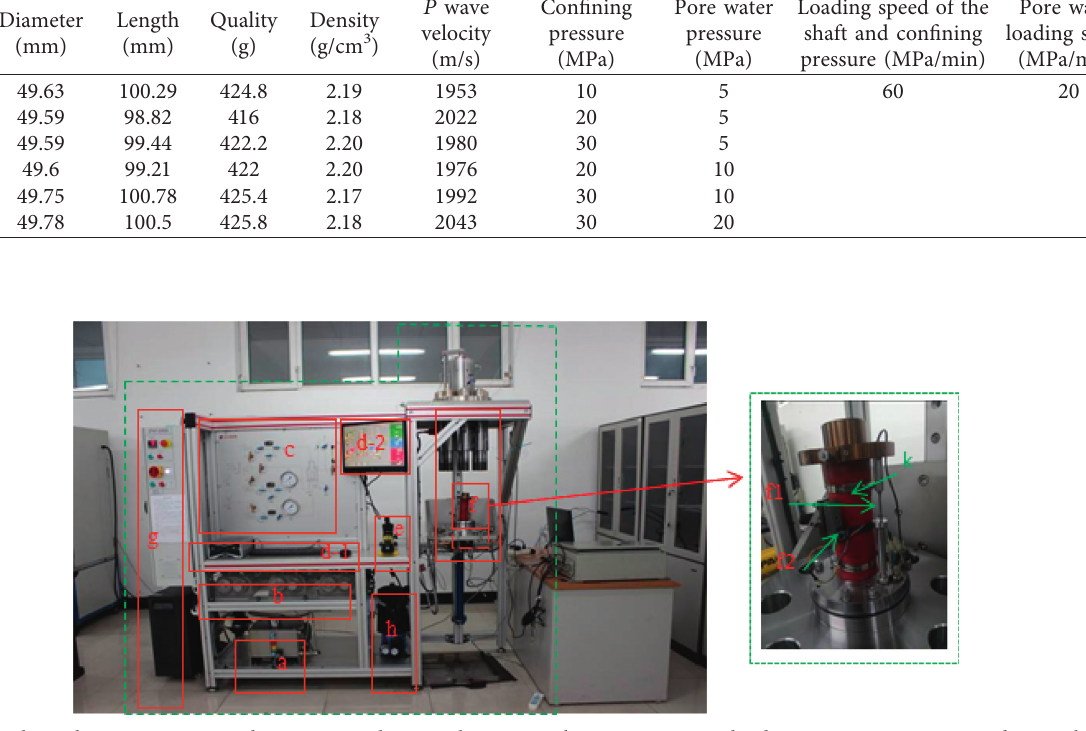
Figure 2: Rock mechanics experimental system. a –oil source, b –axis, enclosure, pore water loading pump, c –monitor and control panel, d –computer acquisition control system, e –base lift pump, f –base (f-1 axial sensor, f-2 radial sensor), g –power, h –pressure pump for confining pressure